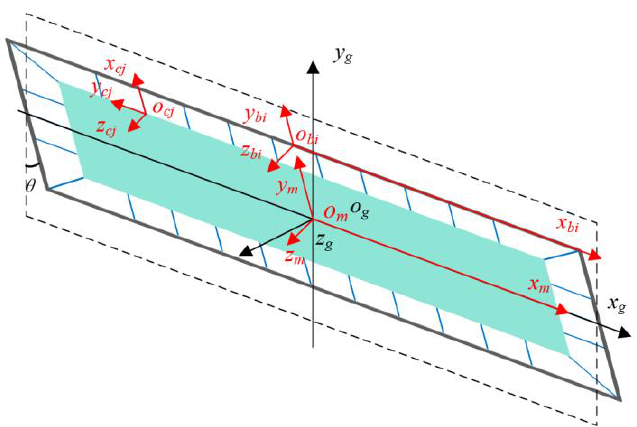
Figure 2. The coordinate systems of space membrane antenna.